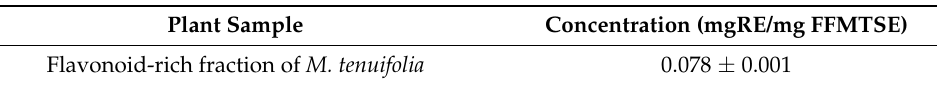
Table 1. Concentration of total flavonoid in FFMTSE. Plant